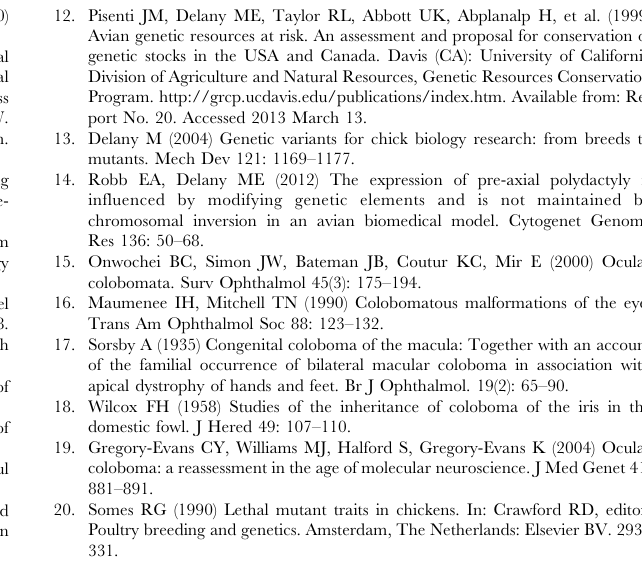
Table S3 Putative Coloboma.003 translocation assess- ment: primer and amplicon information, predicted and actual results. A For the particular Mauve alignment figures, please see [32]. B The Reference genome refers to the normal genome found in the UCSC Genome Browser (http://genome. ucsc.edu). The Translocation genome refers to the Mauve- predicted (putative) translocation and assembly of the coloboma genetic line. C From left to right: the first set of numbers/letters on the left hand size of the primer name refers to the Mauve alignment (e.g., 1–12-Z, Z-1–12, 1-only). Note that primers were designed for only three of the 6 alignments as three of the Mauve alignments were redundant. The ‘‘RefG’’ or ‘‘Co’’ refers to the sequence genome/information from which the primer was designed. The letters after the targeted genome (e.g., P-O, O-G, G-T, P-G, G-O, O-T, R-O, etc.) refers to the section of DNA in each Mauve assembly that primers were designed to flank. For example, under the 1–12-Z Mauve alignment, primers (1–12- Z:Co_P-G) were designed to span the ‘‘pink to green’’ blocks. Lastly, F and R refer to the forward and reverse primers, respectively. See [32] for Mauve alignments. D A dash (–) indicates that no amplification (i.e., no PCR product) is expected. The numbers found in the table refer to the size of the PCR amplicon expected (in basepairs). E Note that the control PCR product produced the proper size amplicon in all samples. Translocation absent indicates that PCR amplicons were visualized based upon the ‘‘translocation absent’’ predictions. Table S4 Chicken EST probes used in whole-mount in situ hybridization: Analysis of UCD-Co.003